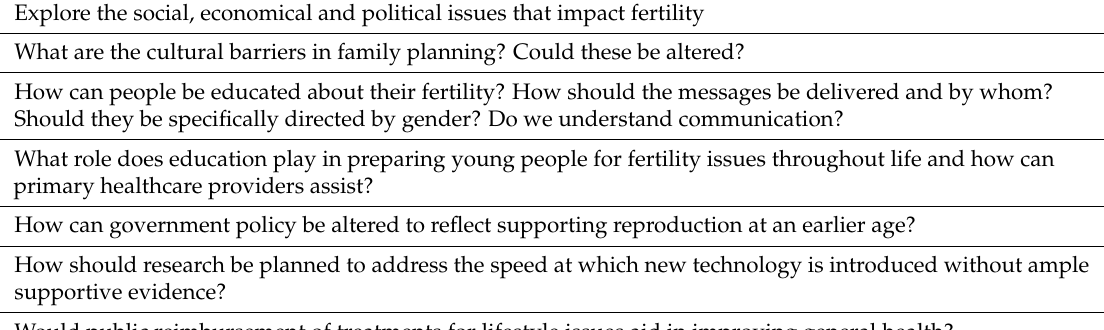
Table 2. Societal factors and preconception health and fertility.